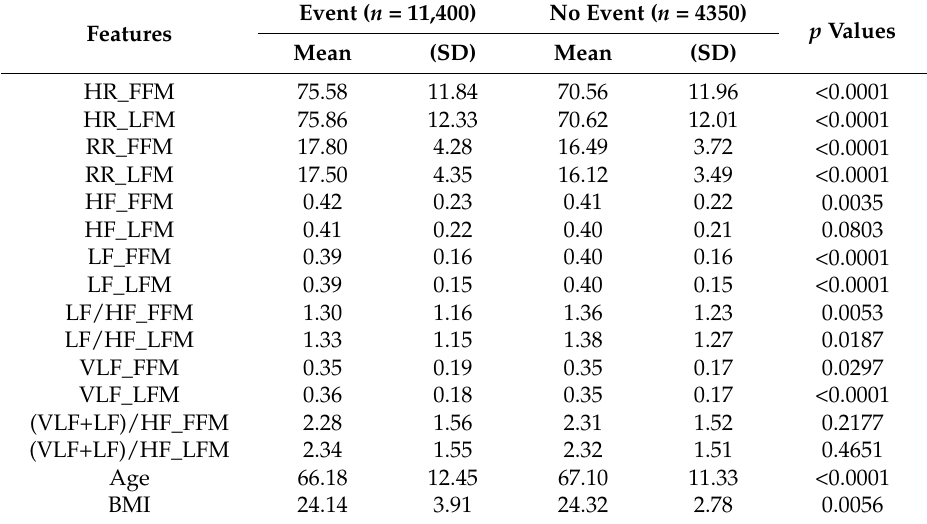
Table 3. Comparison of mean values of various parameters between the event and no-event